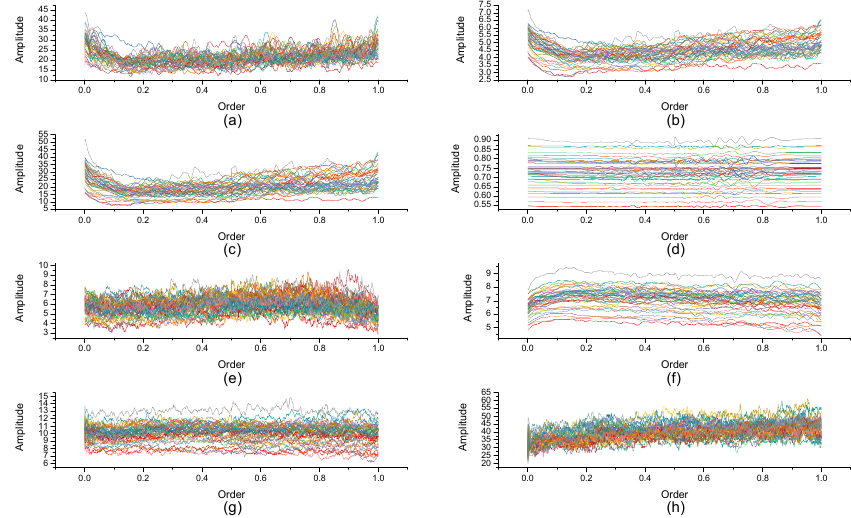
Figure 10. The Order–Amplitude figure of different features of 40 groups for the run action. ( a ) range , ( b ) std , ( c ) var , ( d ) rms , ( e ) IQR , ( f ) mean , ( g ) pksMean and ( h ) pksNum . Micromachines 2019 , 10 , x FOR PEER REVIEW